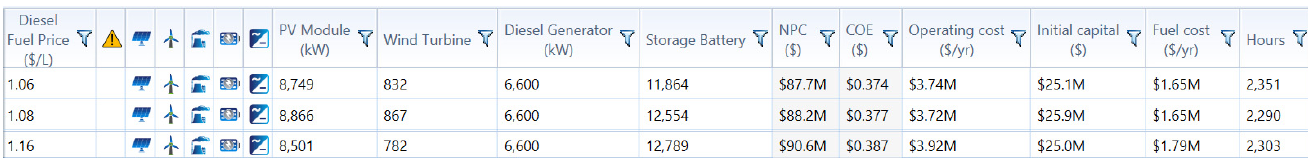
Figure 15. Comparing LCOE of different electrification schemes.